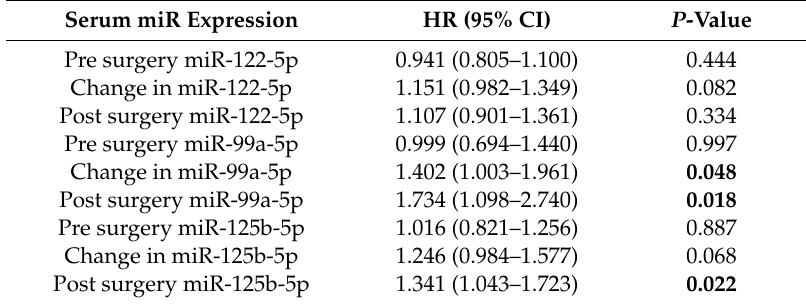
Table 2. Hazard ratios (HR) for PDAC recurrence after resection according to serum miR expression levels Serum miR Expression HR (95%